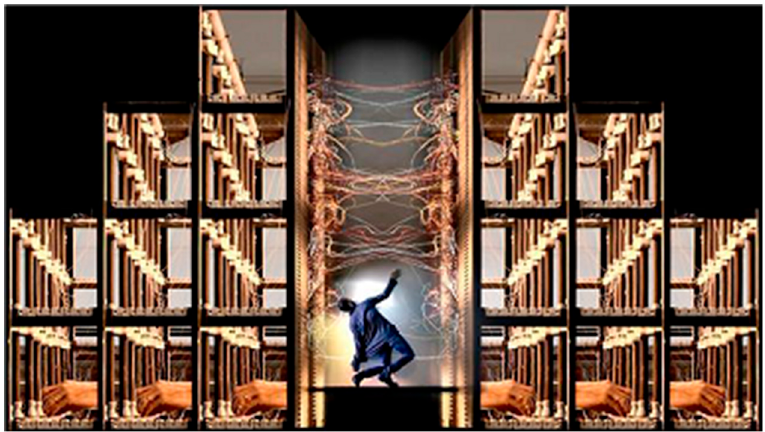
Figure 18. Ronen Sharabani, Conductors and Resistors , 2018. Interactive installation, variable sizes.